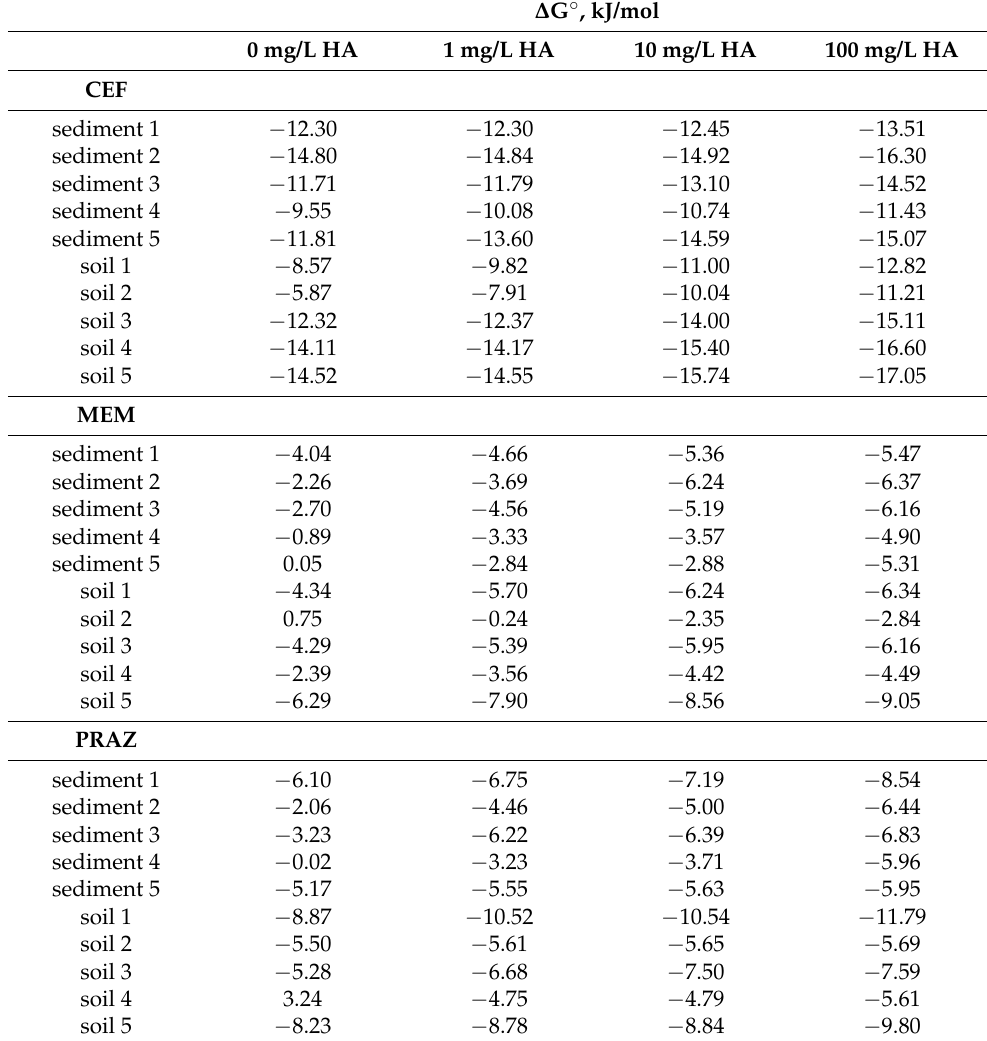
Table 6. Standard Gibbs free energy calculated for different concentration of